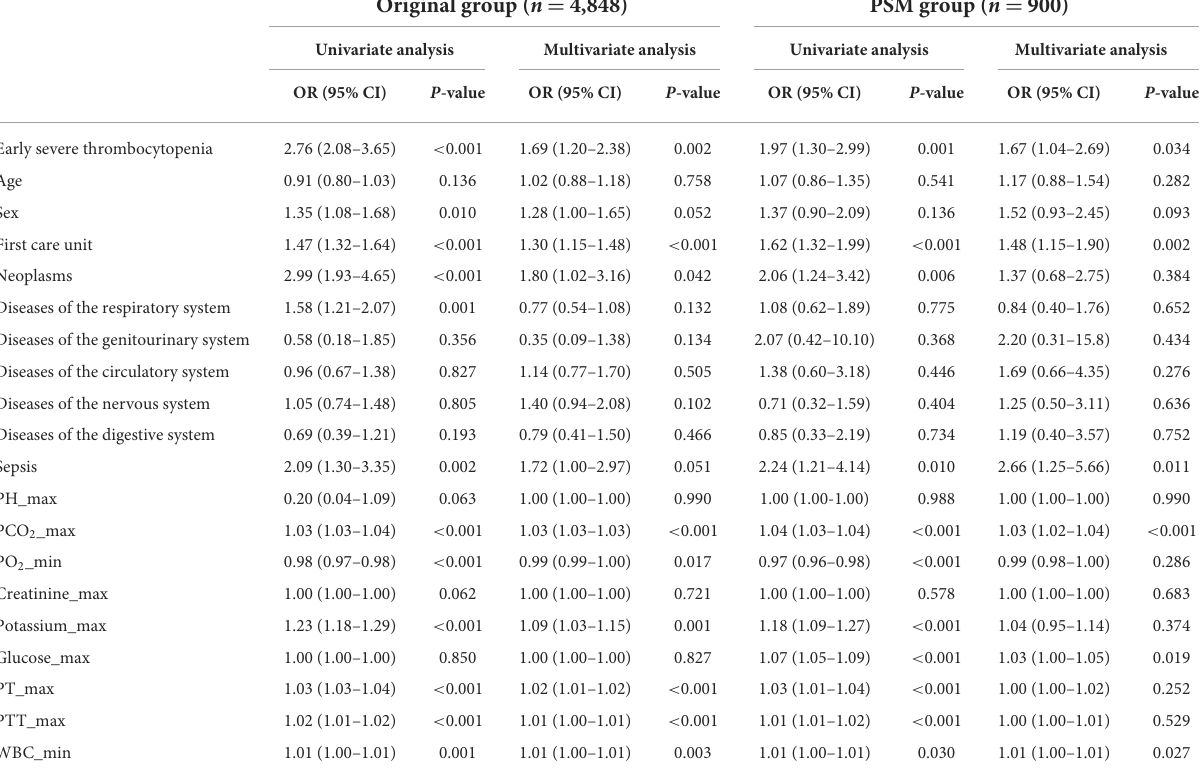
TABLE 2 Univariate and multivariate logistic regression analysis to assess the association between early severe thrombocytopenia and in-hospital mortality in original group and PSM group. Original group ( n = 4,848) PSM group ( n = 900) Univariateanalysis Multivariate analysis Univariateanalysis Multivariate